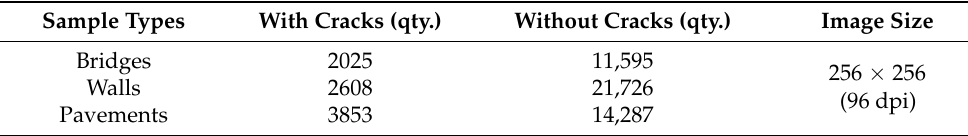
Table 2. SDNET2018 images by type [21].